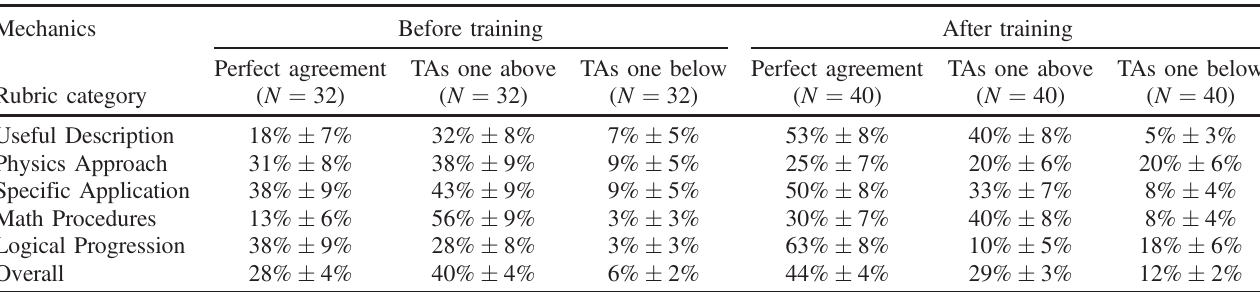
TABLE VI. Percent agreement of third-year graduate student scores with rubric developer scores averaged over all problems before and after training (mechanics problems). The combined agreement within one score is 74 % (cid:2) 2 % before training and 85 % (cid:2) 2 % after training. N is the number of problems scored by the participants in the group ( 4 raters× 8 problems before training; 4 raters× 10 problems after training).